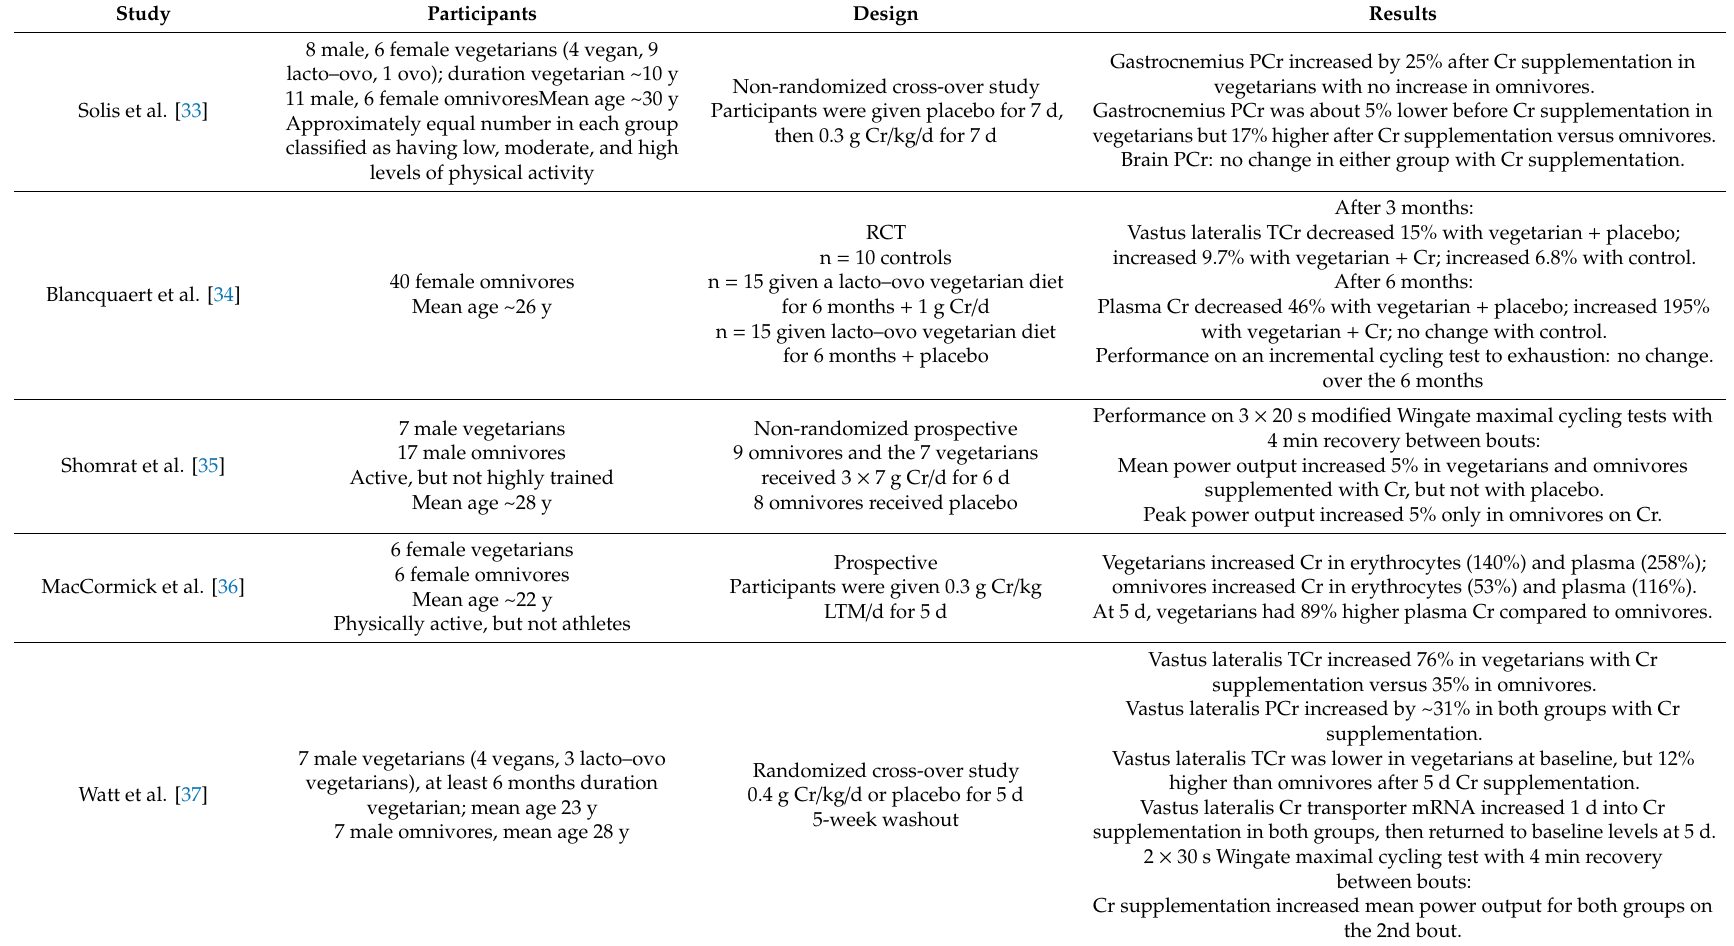
Table 1. Studies involving creatine supplementation in